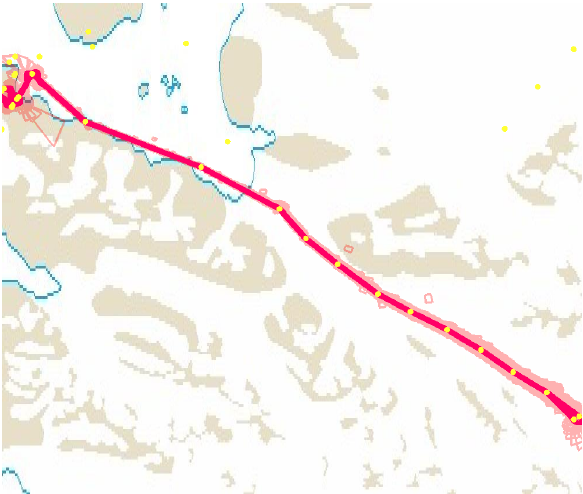
Figure 1: Trajectory of the Cryowing UAS flight (red). The pink polygons represent the coverage of the camera images, and the yellow dots are the flight waypoints. In this paper, we focus on the Kongsvegen